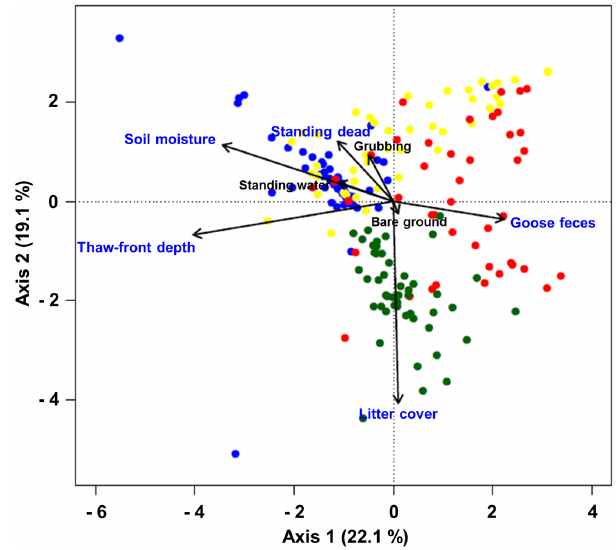
Figure 6. Canonical correspondence analysis ordination diagram of the 197 sites sampled in the Qarlikturvik valley, Bylot Island, Nunavut. Wet polygons ( n = 62): blue circles; <5-year disturbed polygons (n = 44): yellow circles; >5-year disturbed polygons ( n = 43): red circles; mesic environments ( n = 48): green circles. Blue font indicates statistically significant environmental variables (see Table 4). Standing dead represents the cover of dead attached vascular